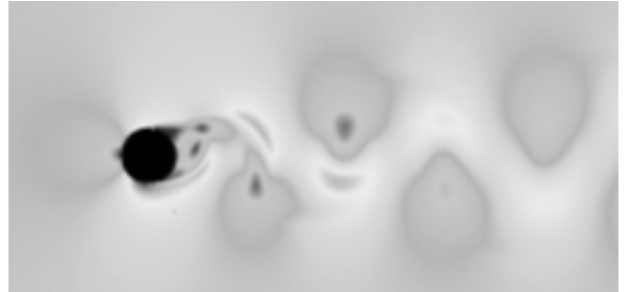
Figure 5. The results of numerical calculations for the k- ω model used in the further part of the work.